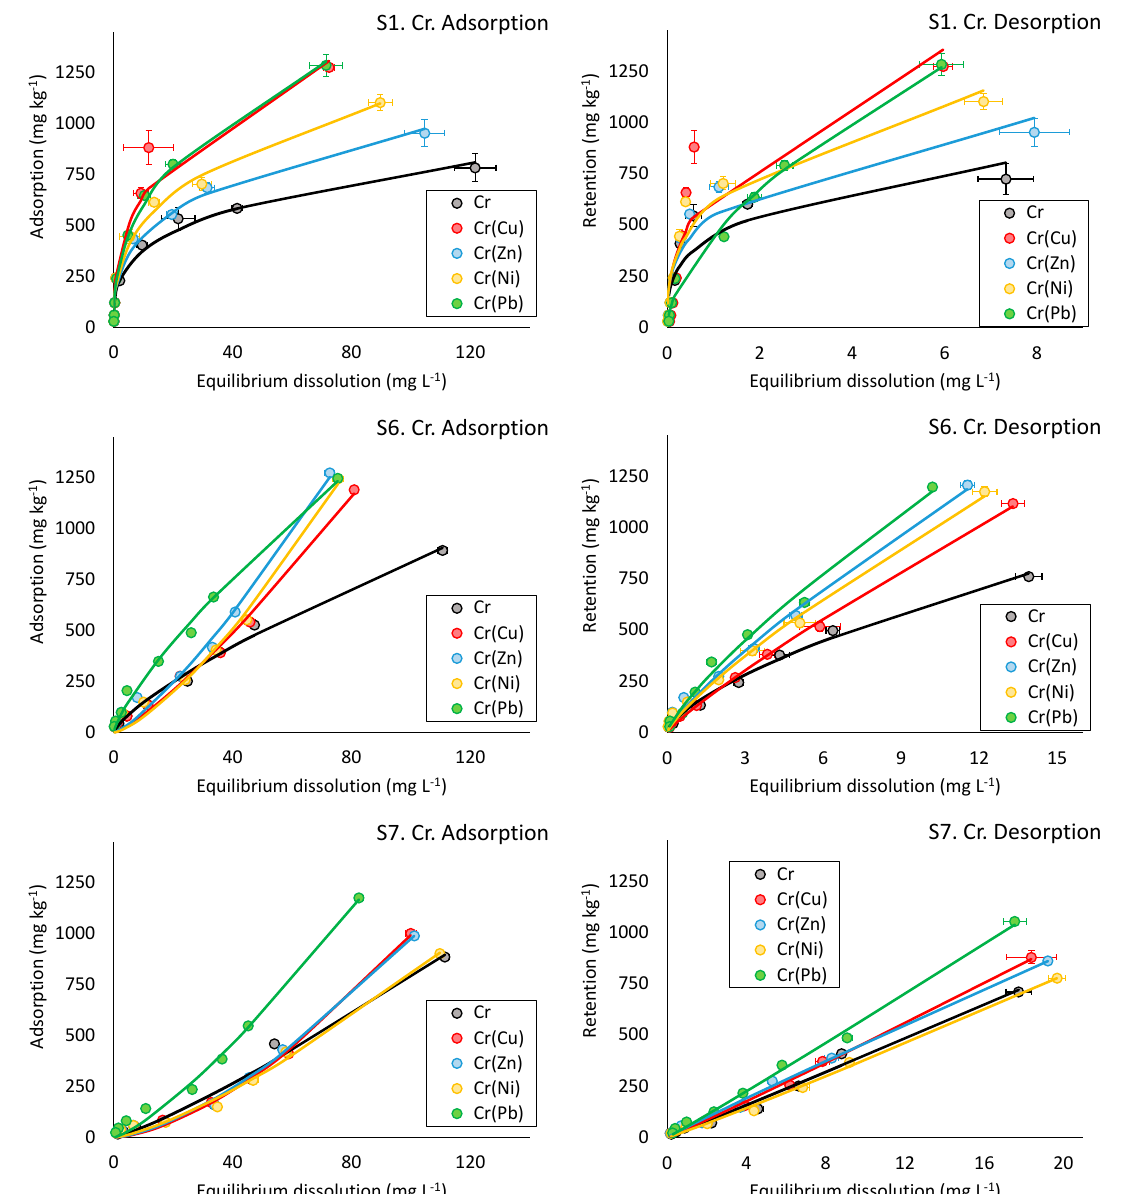
Figure 4. Competitive (coloured) and single (black) adsorption and desorption curves of Cr for soil S1, S6 and S7 samples.